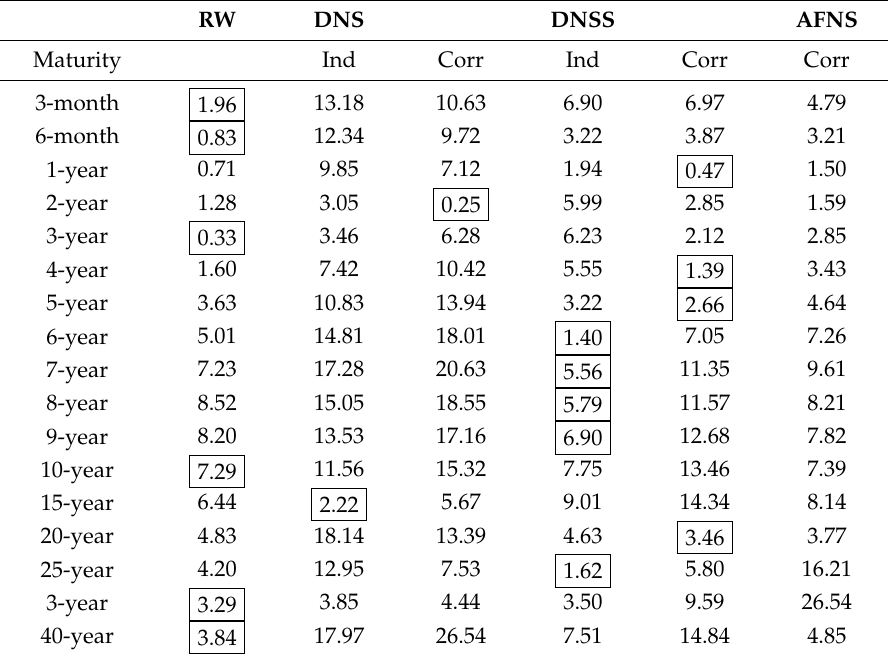
Table 5. Root mean squared forecast error of a 3-month